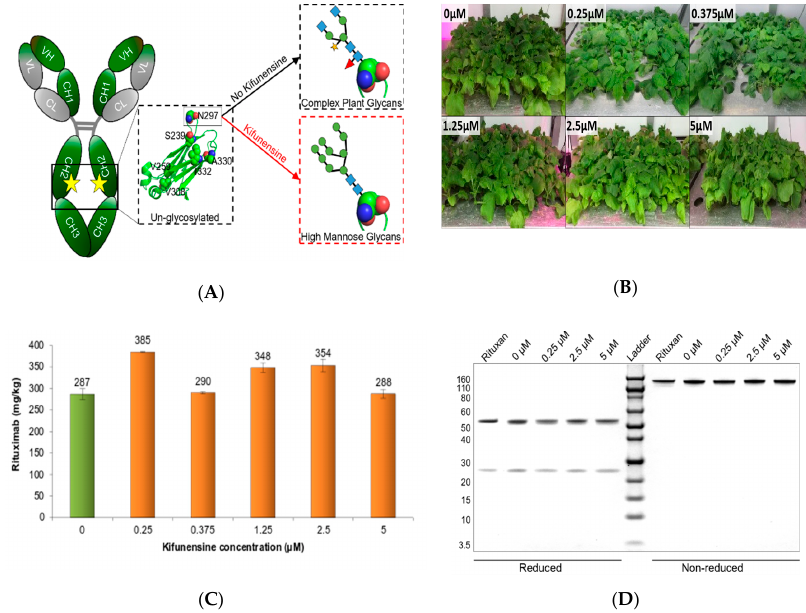
Figure 1. Effect of kifunensine on plant-made rituximab. ( A ) Schematic representation of Immunoglobulin G 1 (IgG1) glycosylation. Complex-type plant glycans (black dotted lines) formed in the absence of kifunensine (black arrow) transformed into Oligomannose-type glycans (red dotted lines) in the presence of kifunensine (red arrow). The oligosaccharide structures are shown in the symbolic depiction suggested by the Consortium of Functional Glycomics (www.functionalglycomics.org). Blue squares -N-acetylglucosamine; Green circles -Mannose; Orange Star- Xylose; and Red Triangle-Fucose. ( B ) Phenotype of N. benthamiana plants infiltrated under vacuum with Agrobacterium suspension ± kifunensine. Each experimental group received different concentrations of kifunensine in the Agrobacterium infiltration solution and concentrations are indicated on top of each treatment image. ( C ) Quantification of rituximab in crude protein extracts using Biolayer interferometry (BLItz ® , ForteBio). Expression levels of rituximab in 7 dpi plant extracts with (orange) and without (green) kifinensine are reported in mg rituximab/kg fresh weight (FW). Error bars represent standard deviations of duplicated expression measurements, where n = 3. ( D ) SDS-PAGE (sodium dodecyl sulfate Polyacrylamide gel electrophoresis) analysis of purified rituximab samples under reduced and non-reduced conditions. Rituxan, plant-made rituximab with no kifunensine, 0.25 µ M kifunensine, 2.5 µ M kifunensine, and 5 µ M kifunensine were separated on a 4–12% Bis-Tris gel along with Novex sharp pre-stained protein